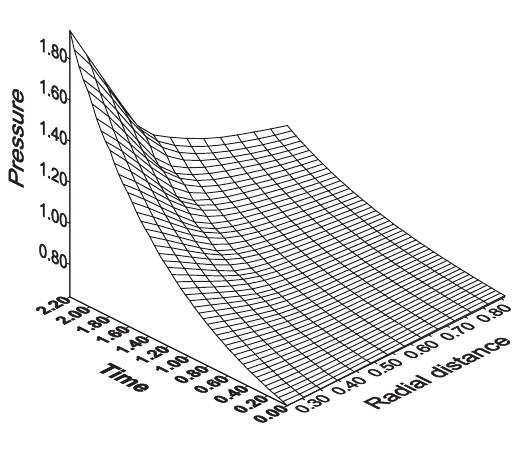
Figure 4.3 . Variation of the heat flux with radial distance and time.